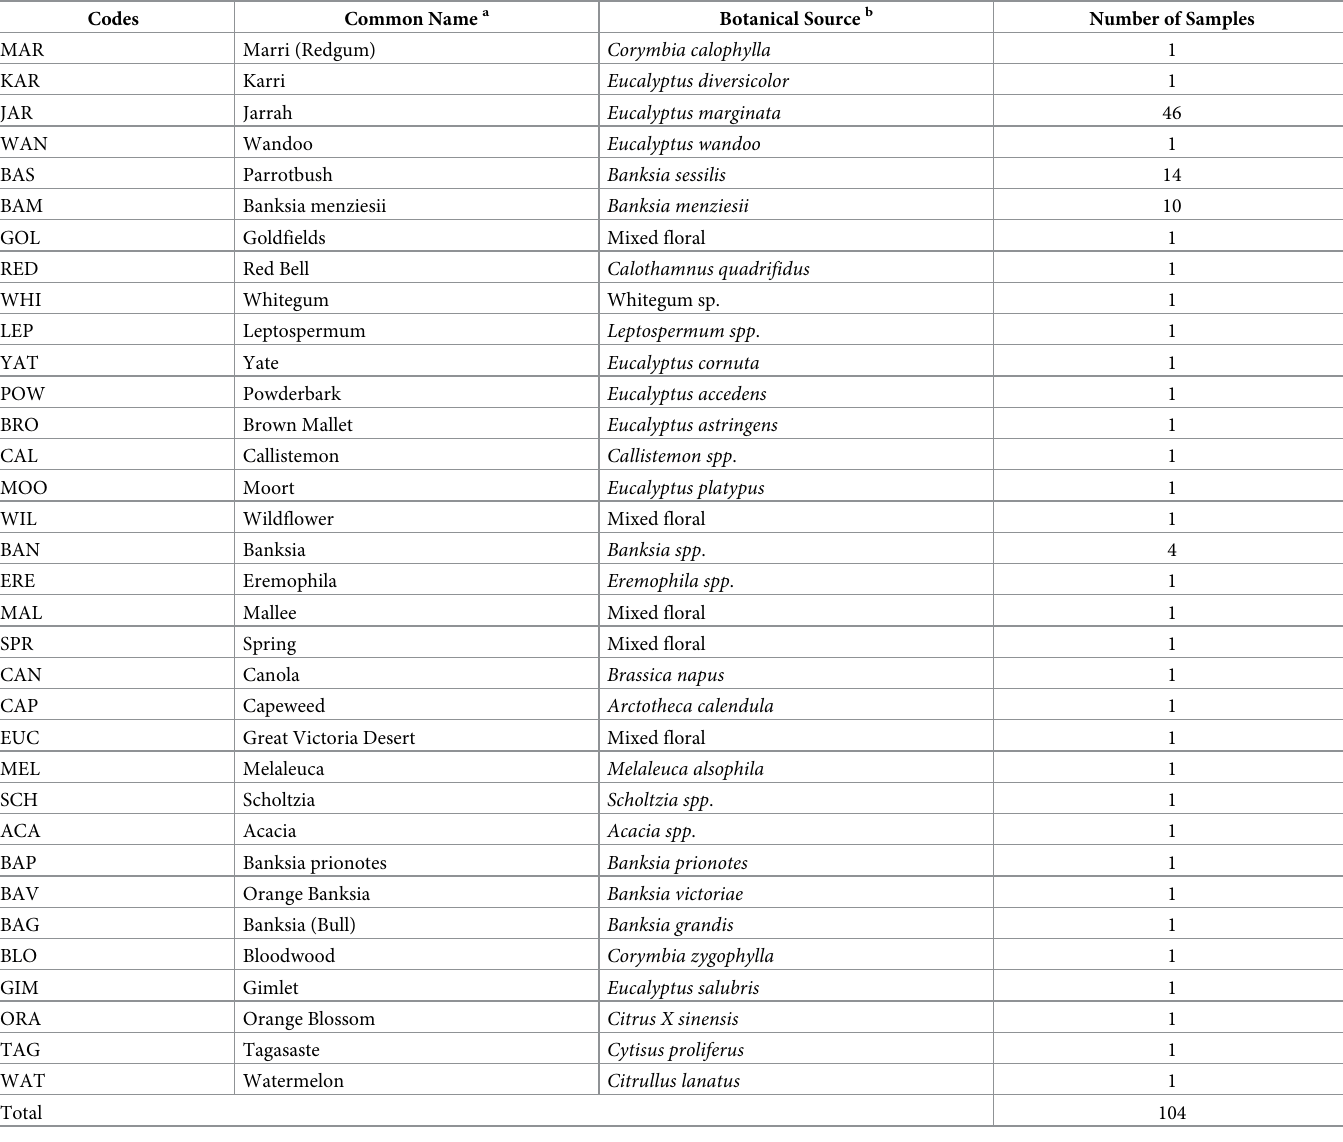
Table 1. Honey samples including codes, common name, botanical source and number of